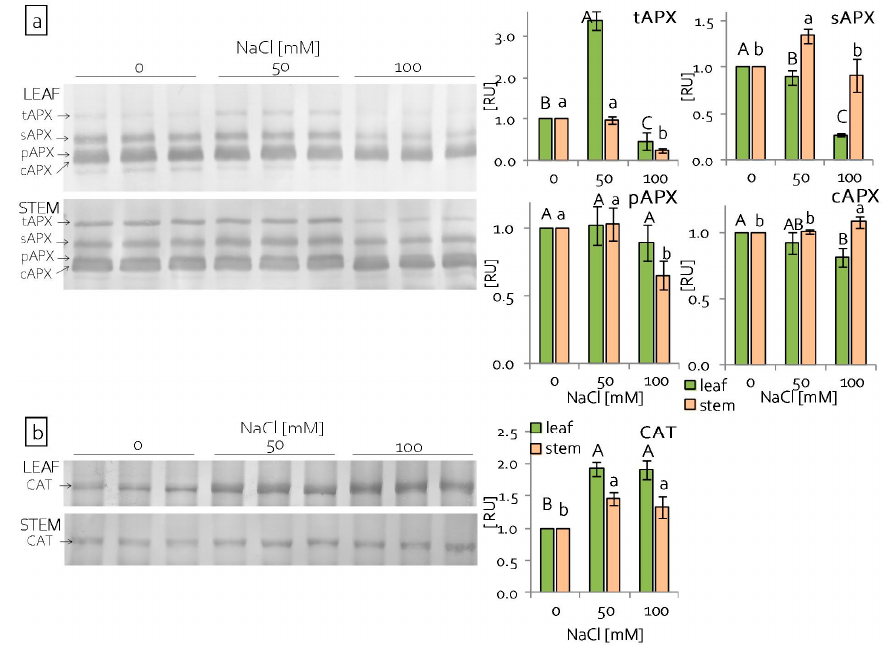
Figure 3. Content of antioxidant enzymes: ( a ) APX isoforms and ( b ) CAT in leaves and stems of grass pea shoots under salinity; tAPX—thylakoid ascorbate peroxidase, sAPX—stromal ascorbate peroxidase, pAPX—peroxisomal ascorbate peroxidase, cAPX—cytoplasmic ascorbate peroxidise, CAT—catalase; content of proteins expressed as relative units [RU]; different letters—statistically significant differences within each organ (leaf-uppercase, stem-lowercase) at p ≤ 0.05 ( n = 3).